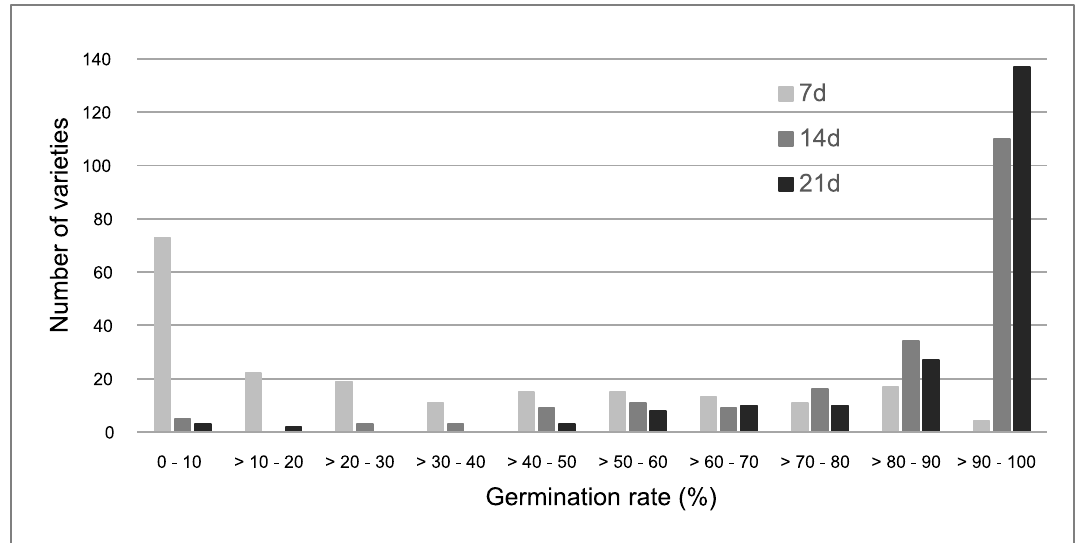
https://doi.org/10.1371/journal.pone.0183416.g002